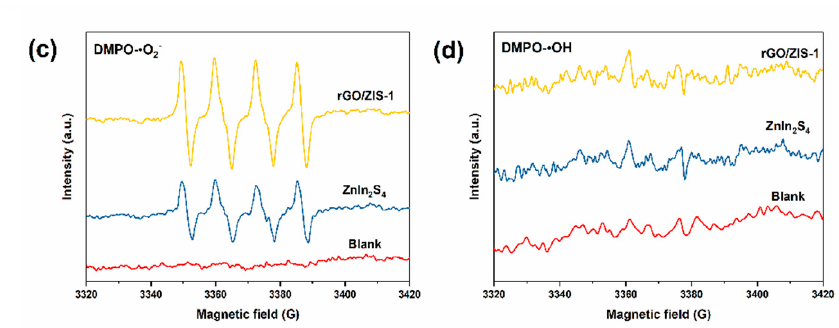
Figure 6. ( a ) NPX photodegradation over rGO / ZIS-1 and ( b ) corresponding degradation e ffi ciency in the presence of 1.0 mM various scavengers; ( c ) EPR spectra of DMPO- • O 2 − and ( d ) DMPO −• OH adducts over di ff erent photocatalysts with irradiation for 5 min. Reaction conditions: [NPX] = 10 mg · L − 1 , [photocatalyst] = 0.2 g · L − 1 , [DMPO] = 100 mM, natural pH, λ > 420